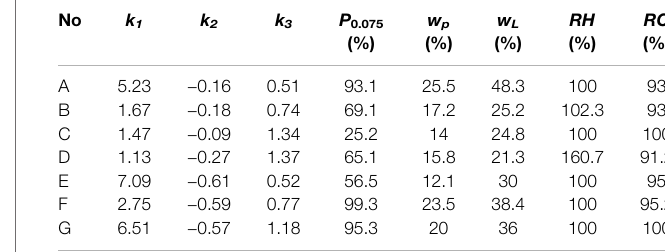
TABLE 3 | Performance-related basic parameters of different